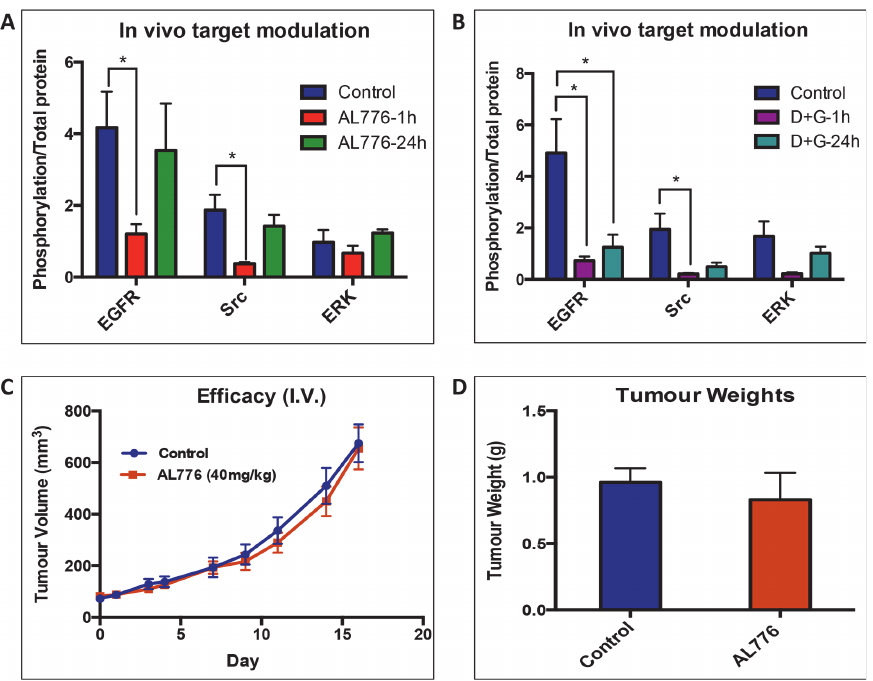
Fig 10. Pharmacodynamics in 4T1 tumours. ( A , B ) Female Balb/c mice (n = 4) bearing 4T1 tumours were treated with 40 mg/kg of AL776, 20 mg/kg each of gefitinib + dasatinib or vehicle and sacrificed 1h and 24h after drug administration (intravenous, i.v). Tumours were collected and western blot analysis was used to detect inhibition of phosphorylation of EGFR, c-Src and ERK1/2 by the drug, at different time points. The bands were quantified and represented as histograms and as a ratio of phospho-protein/total protein. Statistical significance was determined using multiple t-test and p < 0.05 was considered significant. ( C ) Efficacy study was carried out in female Balb/c mice (n = 6) bearing 4T1 tumours and treated with 40 mg/kg of AL776 or vehicle administered IV (once/day) for 5 consecutive days. Tumour growth was monitored for two weeks by measuring tumour volume on alternate days. Graphs representing the average tumour volumes ± SEM of the two groups are shown. ( D ) On the last day of the study, tumours were collected and their average ± SEM weight (g) from AL776 treated and the control groups (n = 6) are plotted as